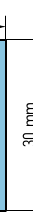
Fig. 2. Layout of two inner layers of the U-shape channel in the 3D LTCC module (source: own edition)